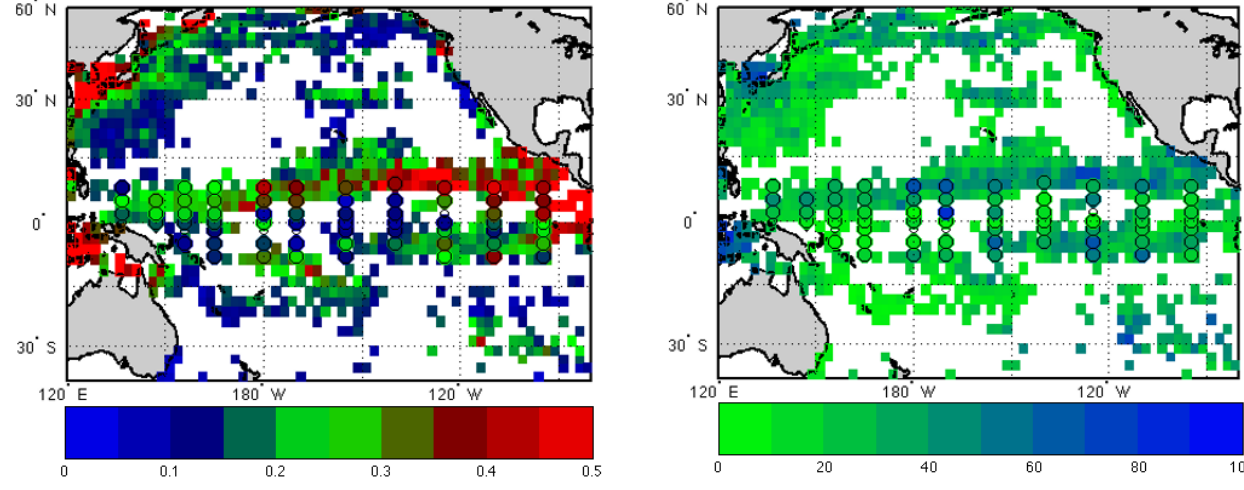
Fig. 3. Amplitude of the seasonal cycle of SLS from the combined dataset. Color scale is shown at bottom. Areas with no fill had ob- servations, but from those observations no significant seasonal com- ponent was found. Seasonal cycles from TAO/TRITON moorings are shown in circles near the equator. Small empty circles indicate that mooring data were examined, but no significant seasonal cycle was found for that mooring.